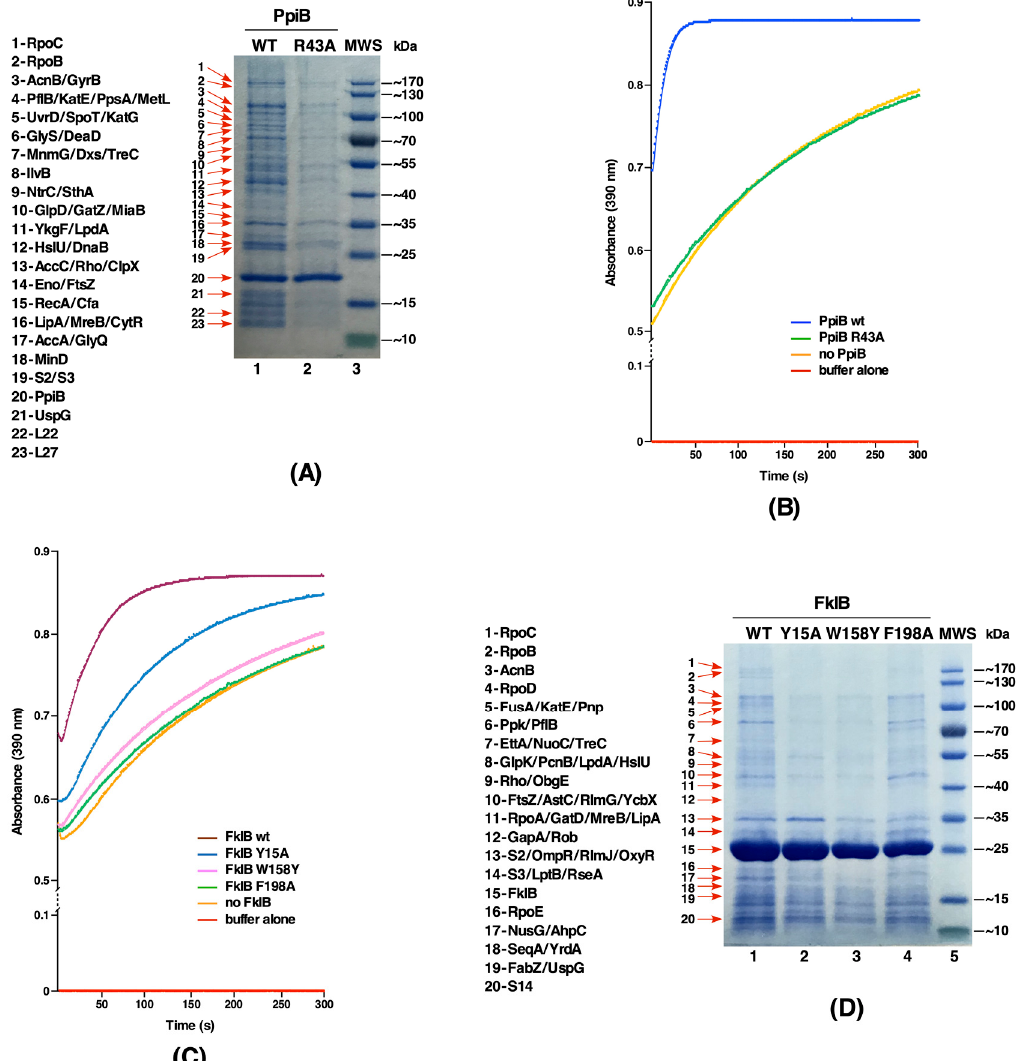
Figure 6. Identification of substrates of PpiB and FklB. ( A ) Co-purification profile of wild-type PpiB and PpiB R43A proteins. Co-eluting proteins present in the wild-type that are either absent or with reduced abundance are indicated. ( B ) The PPIase activity in the chymotrypsin-coupled assay with purified wt PpiB and PpiB R43A (0.5 µ M each) is indicated. Controls without enzyme and bu ff er are also plotted. ( C ) The PPIase activity in the chymotrypsin-coupled assay with 0.5 µ M purified FklB variants in comparison to the wild-type FklB, without enzyme and bu ff er alone are plotted. ( D ) Co-purification profile of wild-type FklB, and its derivatives Y15A, W158Y and E86A. Proteins were resolved on a 12.5% SDS-PAGE and co-eluting proteins are indicated and their identity shown.